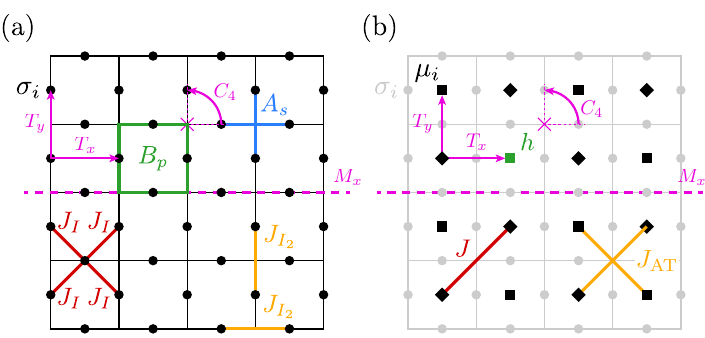
Figure 1: (a) Toric Code model with Ising interactions among nearest neighbor ( J ) I and next-nearest neighbor sites along the edges of the lattice ( J ), Eq. (1). The spin I 2 variable on site i is denoted as σ . The A ( B ) operators live on stars (plaquettes) i s p of the lattice. In pink, we additionally show the space group symmetry generators: translations T , mirror reflection M , vertex-centered 4-fold rotation C . (b) Trans- x , y x 4 verse field Ising model with 4-spin interactions, Eq. (2), on the dual square lattice with spin variables µ . The original lattice is depicted in light-grey for reference. i Squares (diamonds) indicate the sublattice A (B). The mapping of the interactions of the TCI model (a) to the interactions in the AT-TFI model (b) is sketched by using the same colors for mapped interactions. Note that, for better readability, we only illustrate the mapping of one interaction of each type in